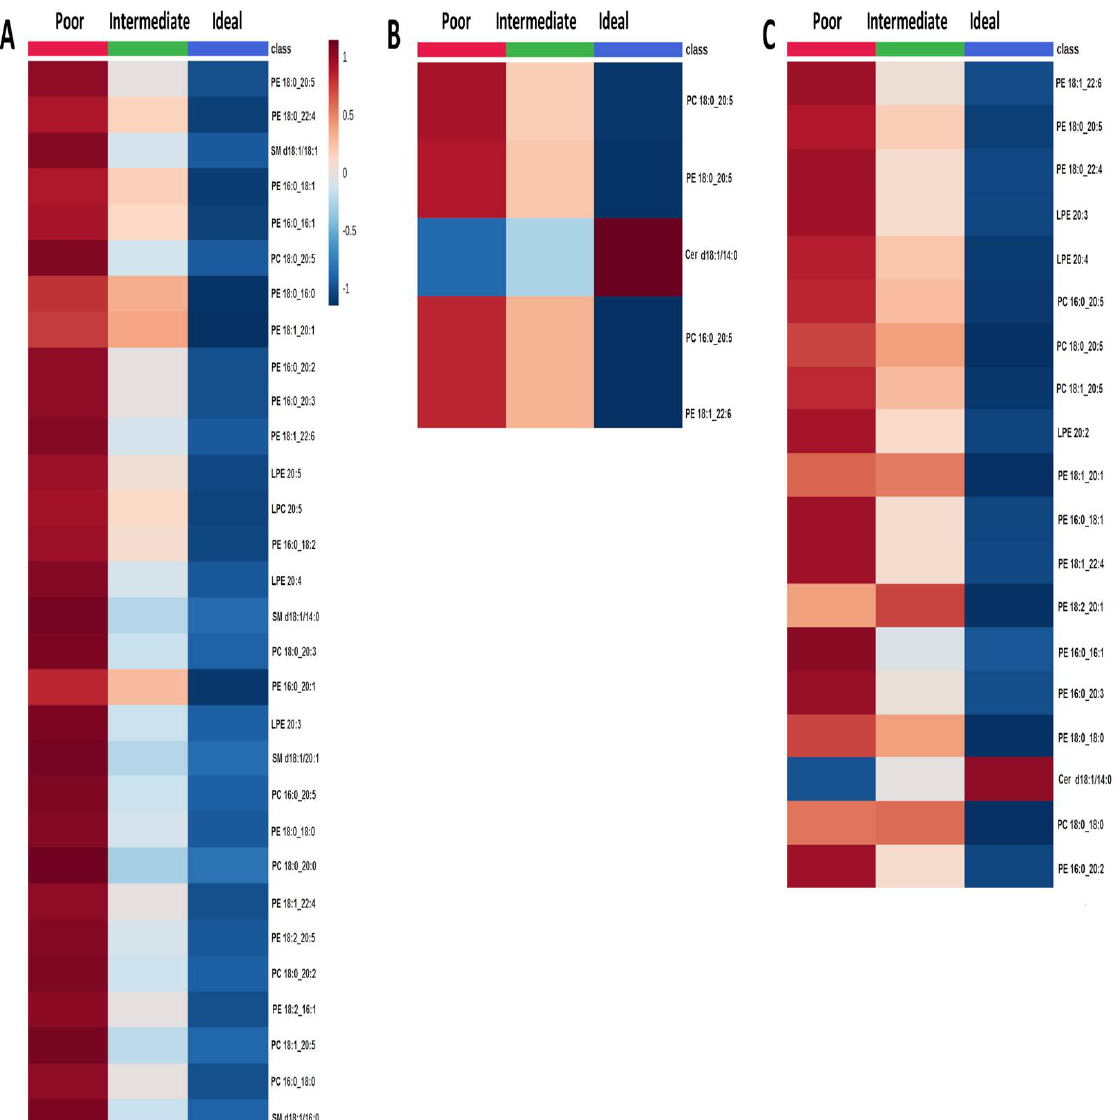
Figure 3. Comparison of lipid species across categories of 564 ( A ) blood pressure, ( B ) total cholesterol, and ( C ) fasting blood glucose metrics. The heatmap shows the average concentrations of important lipid features identified by the ANOVA analysis and grouped by categories of each metric.